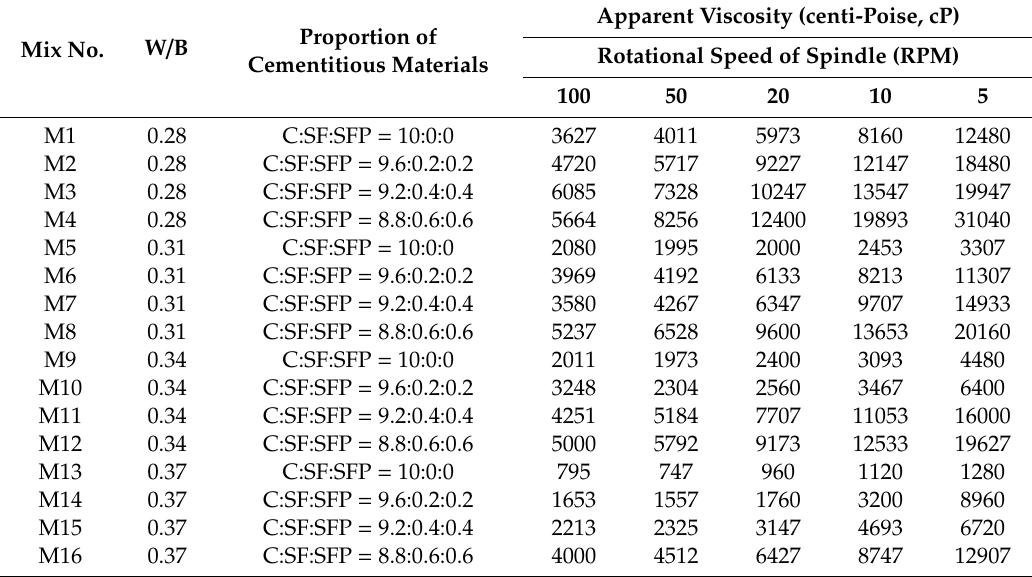
Table 8. Results of the apparent viscosity of matrixes.